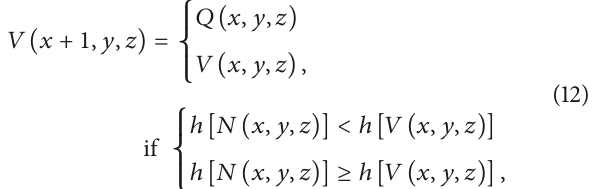
Figure 6: The flowchart of the proposed